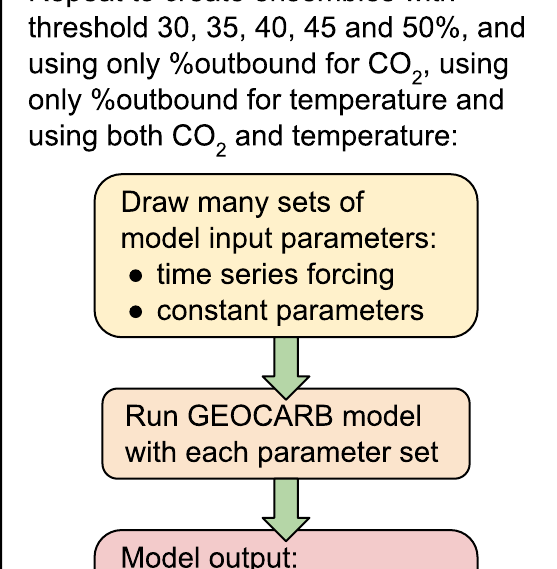
data. Figure 1 gives a schematic depicting the precalibration work fl ow.